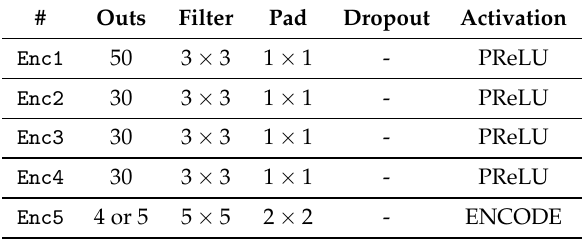
Table 4. Automatic feature extraction experiments, labeled as AF4 and AF5 , use adjustable encoders (Figure 2) with multiple convolutional layers. The layout of the layers and the corresponding activation functions (including PReLU [35]) are presented. The ENCODE activation function is a short term for a sequence of operations: the PReLU activation function, the absolute value, the layer that modifies gradients with relation to kurtosis (Section 3.2), and local-maximum filtering with radius s = 3. #